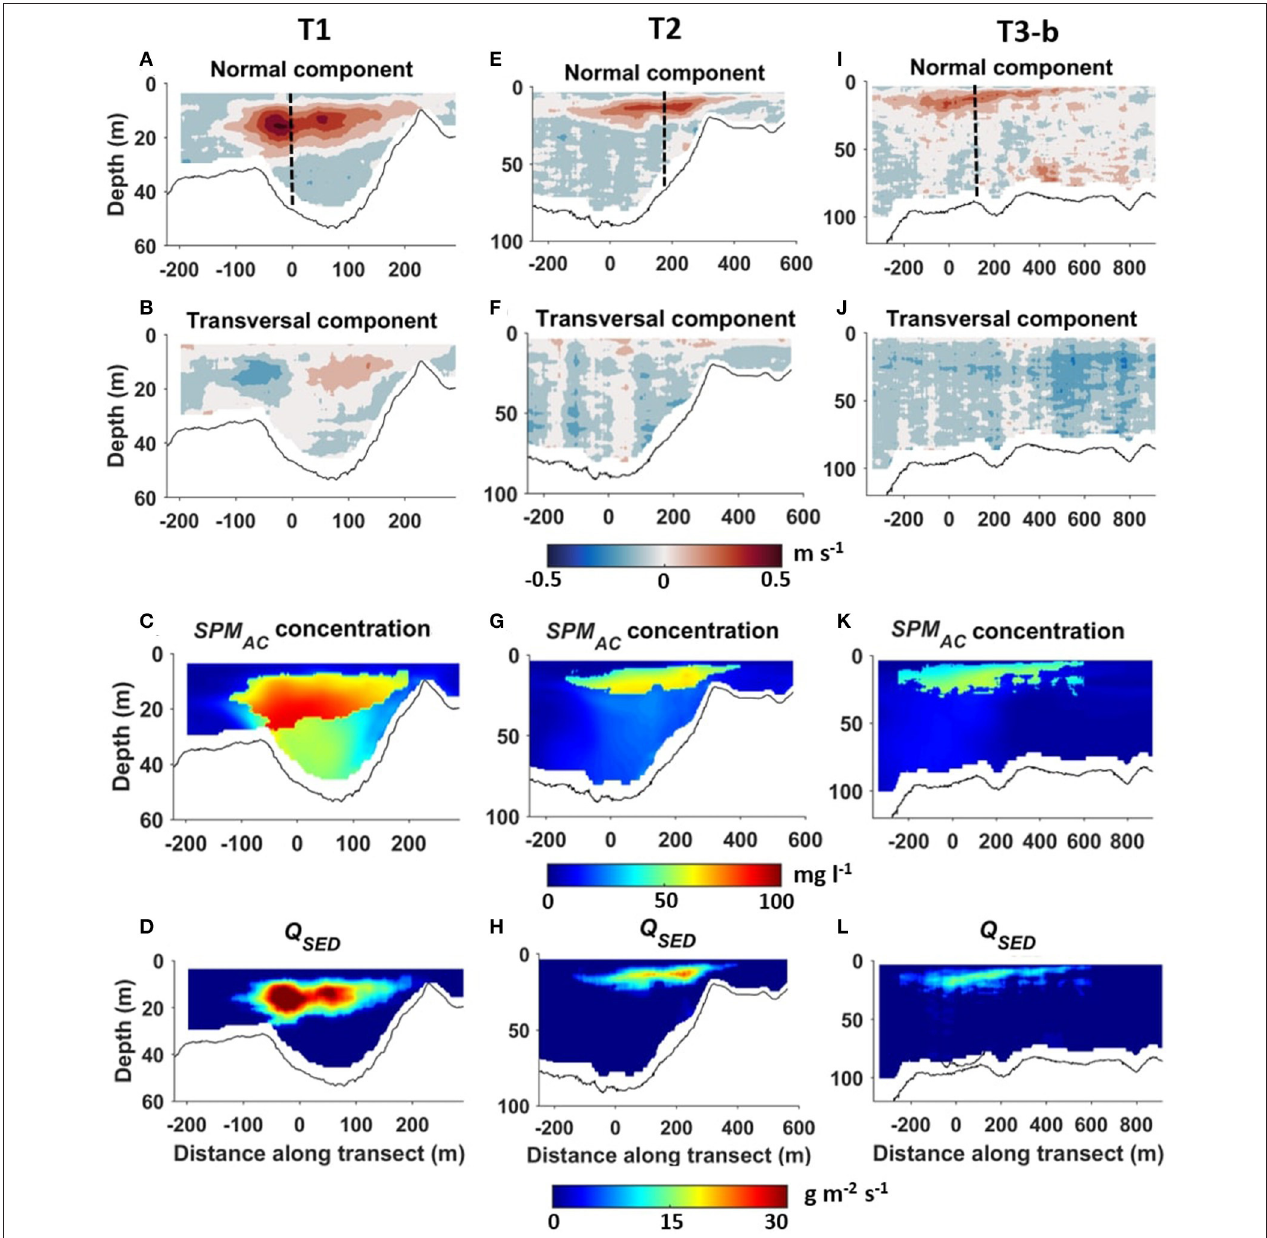
FIGURE 4 | (A,E,I) Normal ( u ) and (B,F,J) transversal ( v ) velocity components, (C,G,K) SPM AC concentrations and (D,H,L) suspended sediment discharge Q SED for transects T1, T2 and T3-b on 11 July 2018. Refer to Figure 1B for transect locations. The dashed lines correspond to the positions of stations P1, P2 and P3-a. Colorbars give parameter